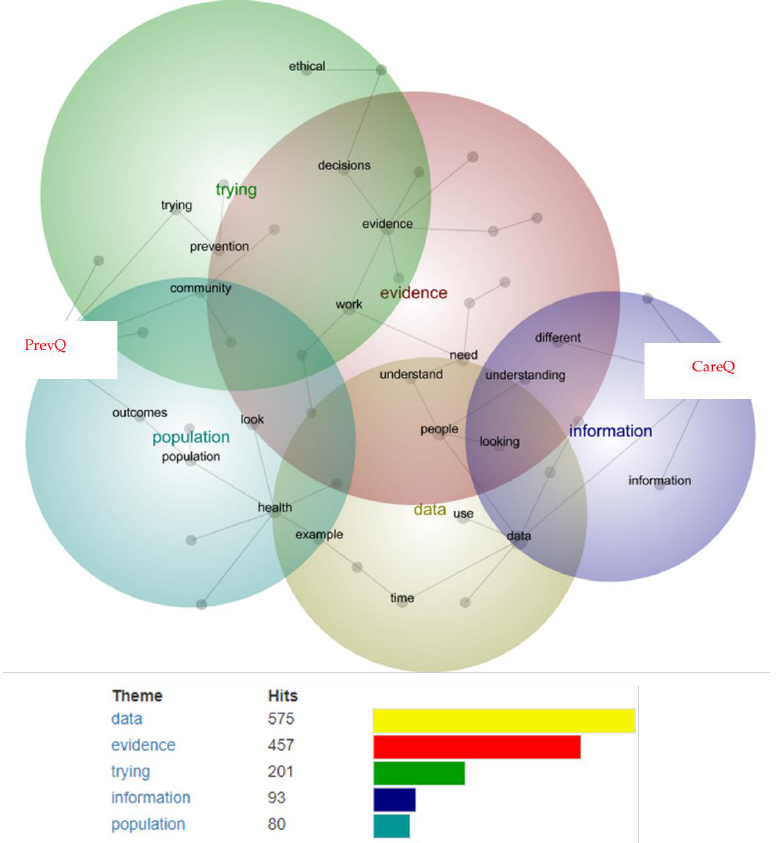
Figure 3. Concept map from Leximancer data analysis stratified by organisation (PrevQ, CareQ). Box 6. Participant quotes supporting subgroup analysis (organisation).